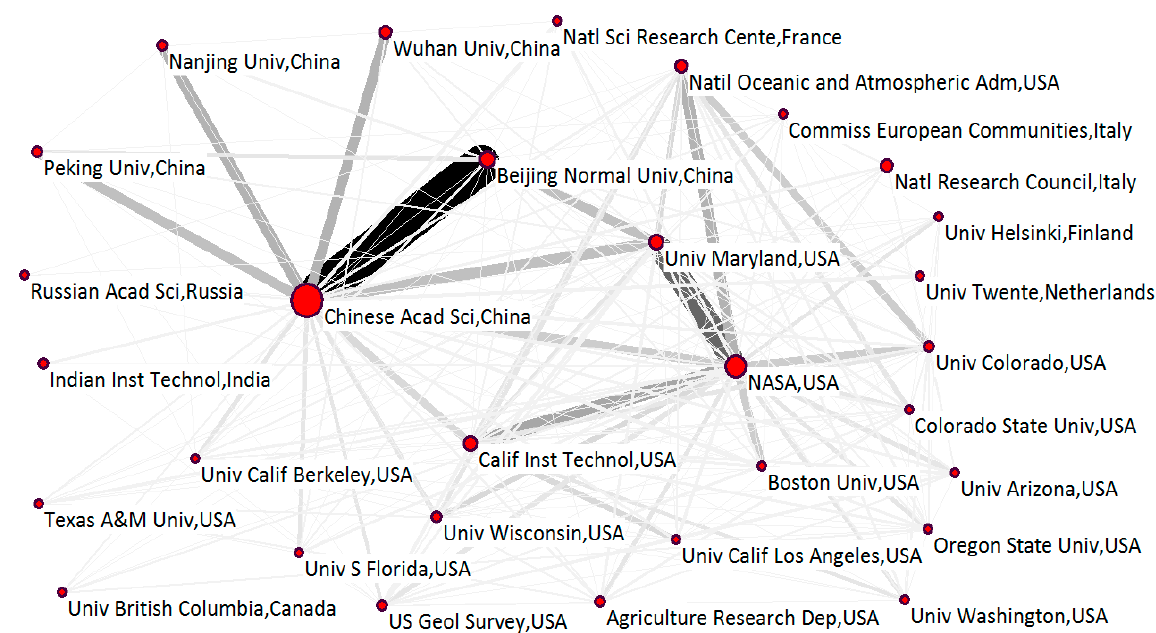
Figure 2. Institutional collaboration according to social network analysis.